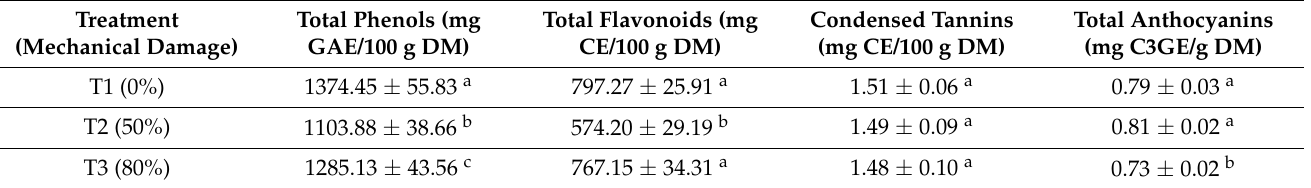
Table 4. Total phenolic compounds, total flavonoids and condensed tannins in Tepary bean ( Phaseolus acutifolius )